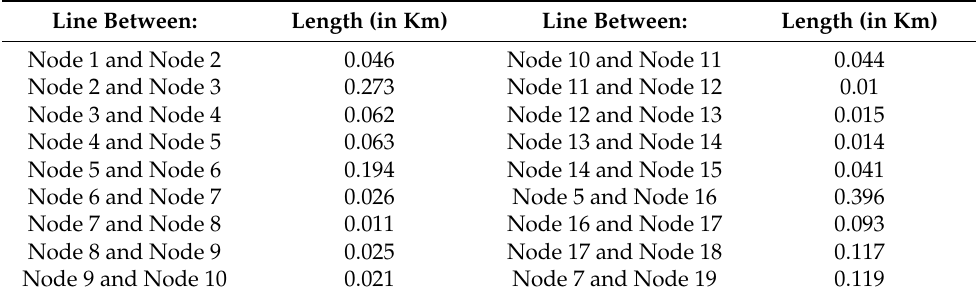
Table A1. Line lengths of the studied LV